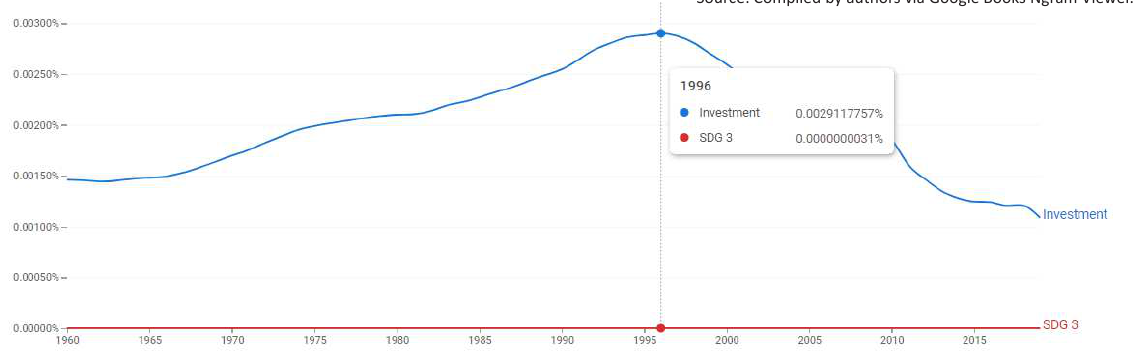
Figure 6. Ngram concerning “SDG 3 and investment” in 1960–2019